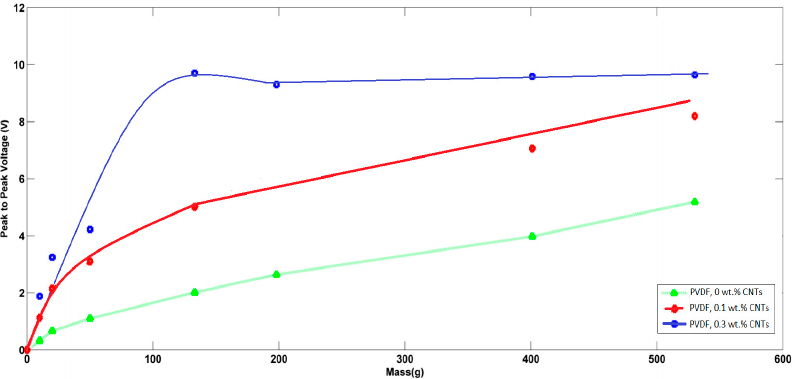
Figure 11. Piezoelectric response of aligned nanofibers at different added weight ratios of CNTs.